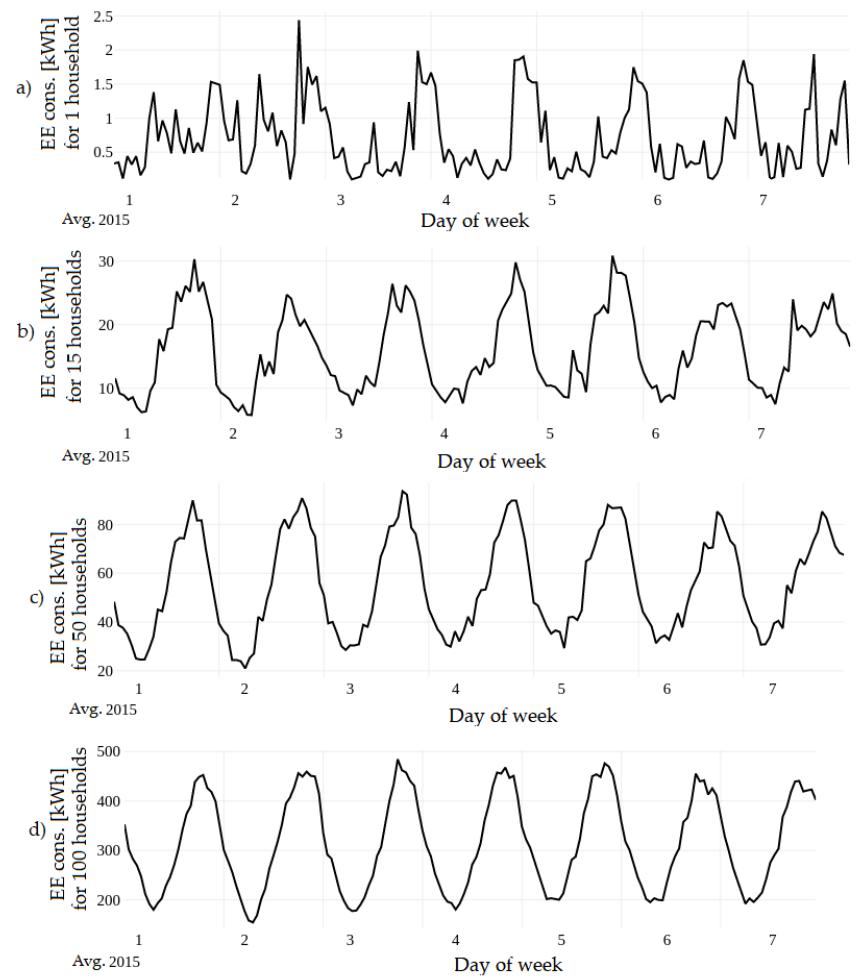
Figure 1. Weekly electrical energy (EE) consumption of: ( a ) 1 household, ( b ) 15 households, ( c ) 50 households, ( d ) 100 households.